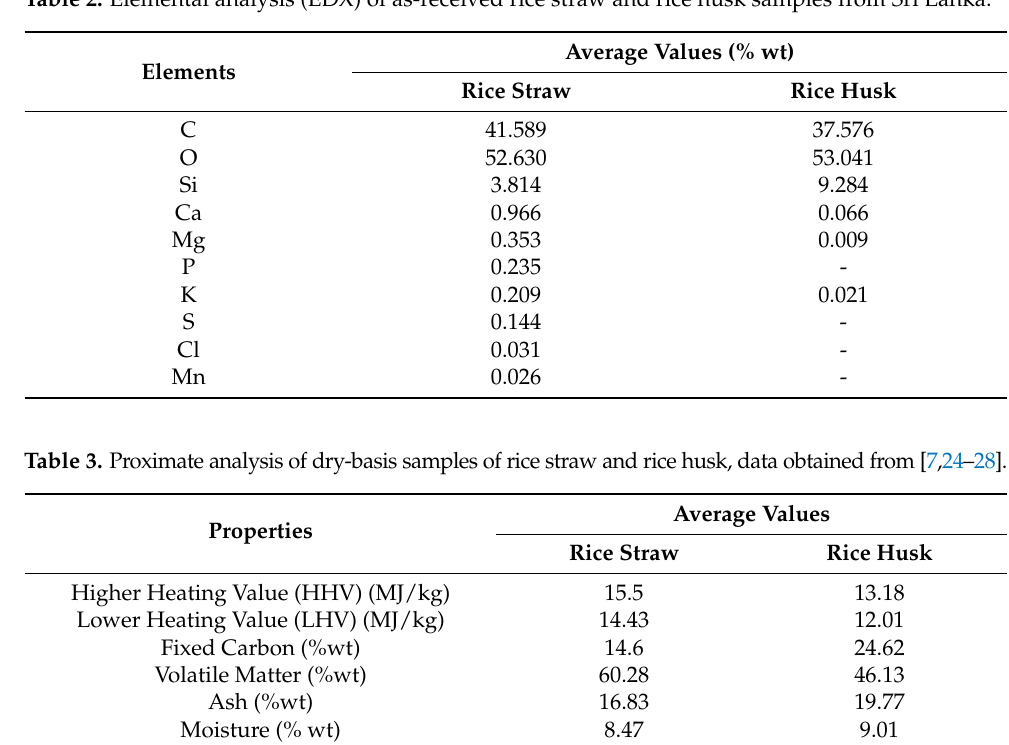
Table 2. Elemental analysis (EDX) of as-received rice straw and rice husk samples from Sri Lanka.